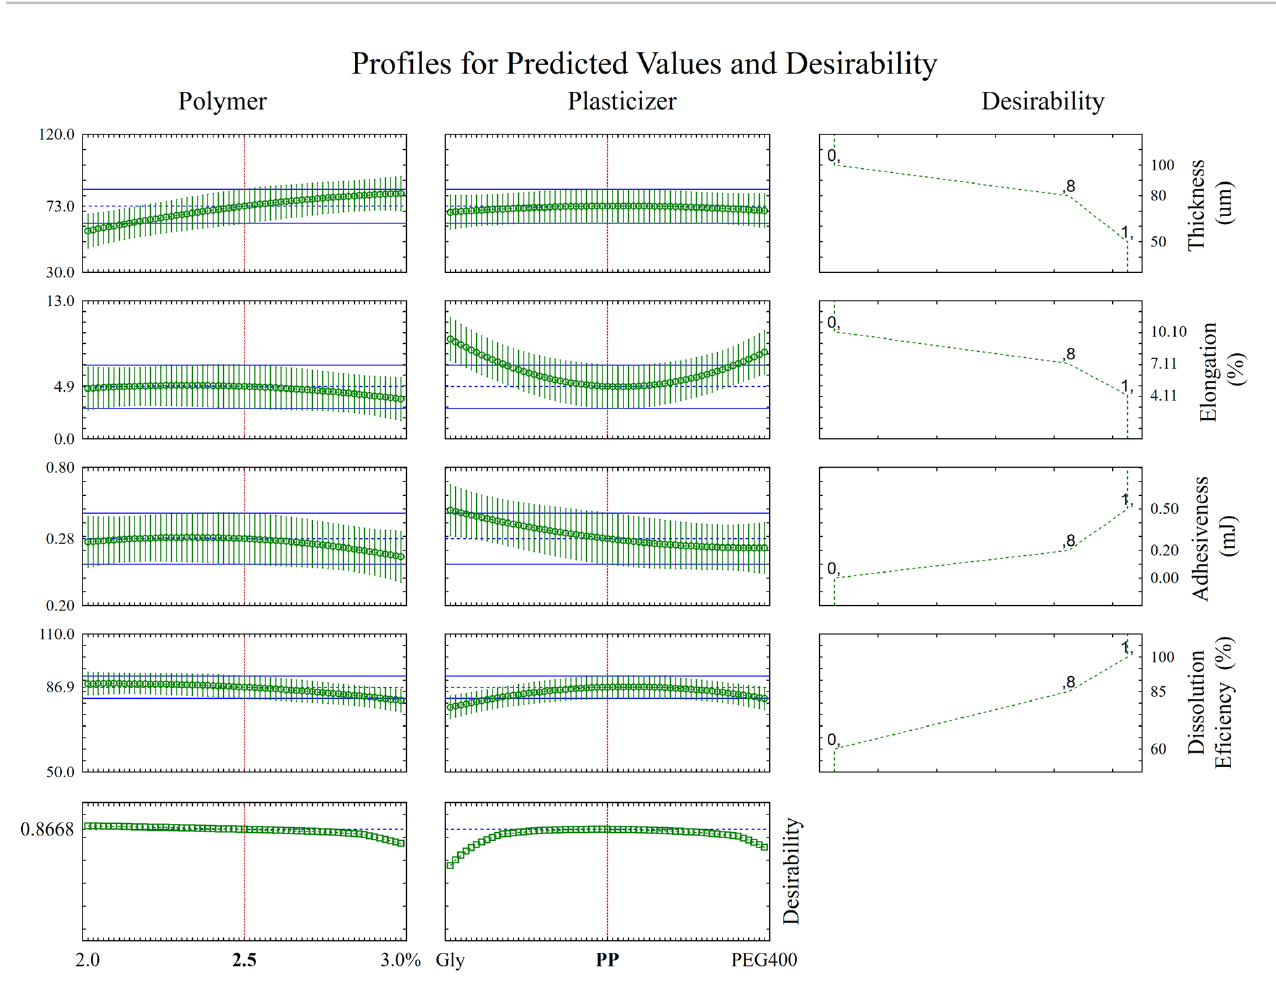
FIGURE 7 - Global desirability function ( f